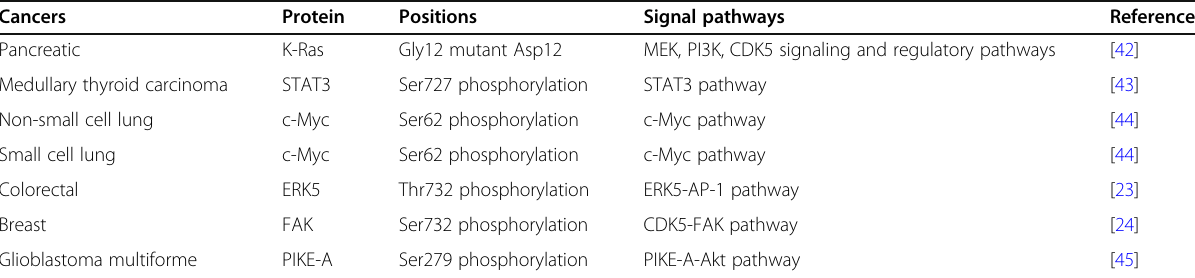
Table 2 CDK5 mediated phosphorylation events in